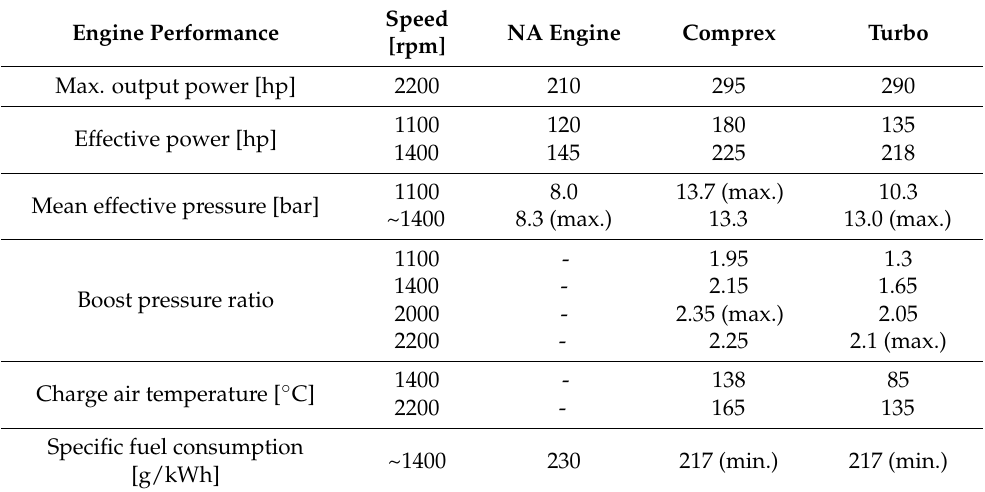
Table 2. Comparative data when NA and when using Comprex or Turbo-compressor with a 11.1 L Diesel engine (1970)